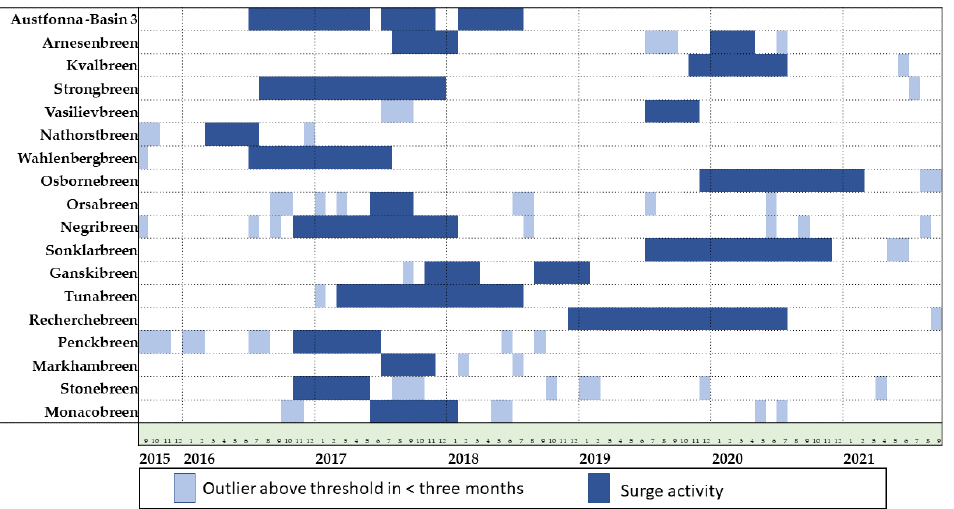
Figure 5. Gantt chart of the onset (dark blue) and duration of 18 acceleration phases of surges of Svalbard glaciers from 2015 to 2021.